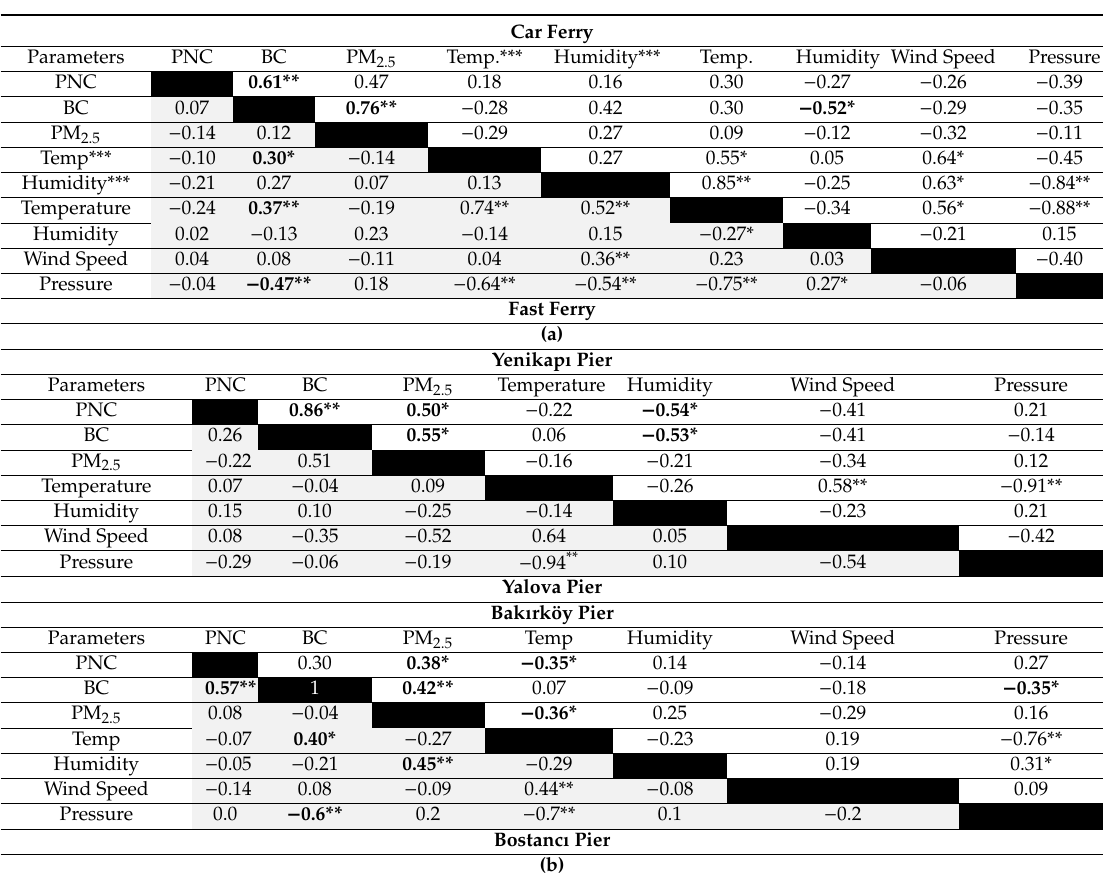
Table 5. Pearson correlation coe ffi cients between pollutants trip-averaged concentration and meteorological variables for (a) inside car ferry and passenger ferry, (b) at the pier. Bold numbers indicate significant correlation coe ffi cients at p-values (**: p < 0.01; *: p < 0.05), Grey backgrounds show the correlation coe ffi cients for fast ferry, Yalova pier and Bostancı pier. *** in-ferry